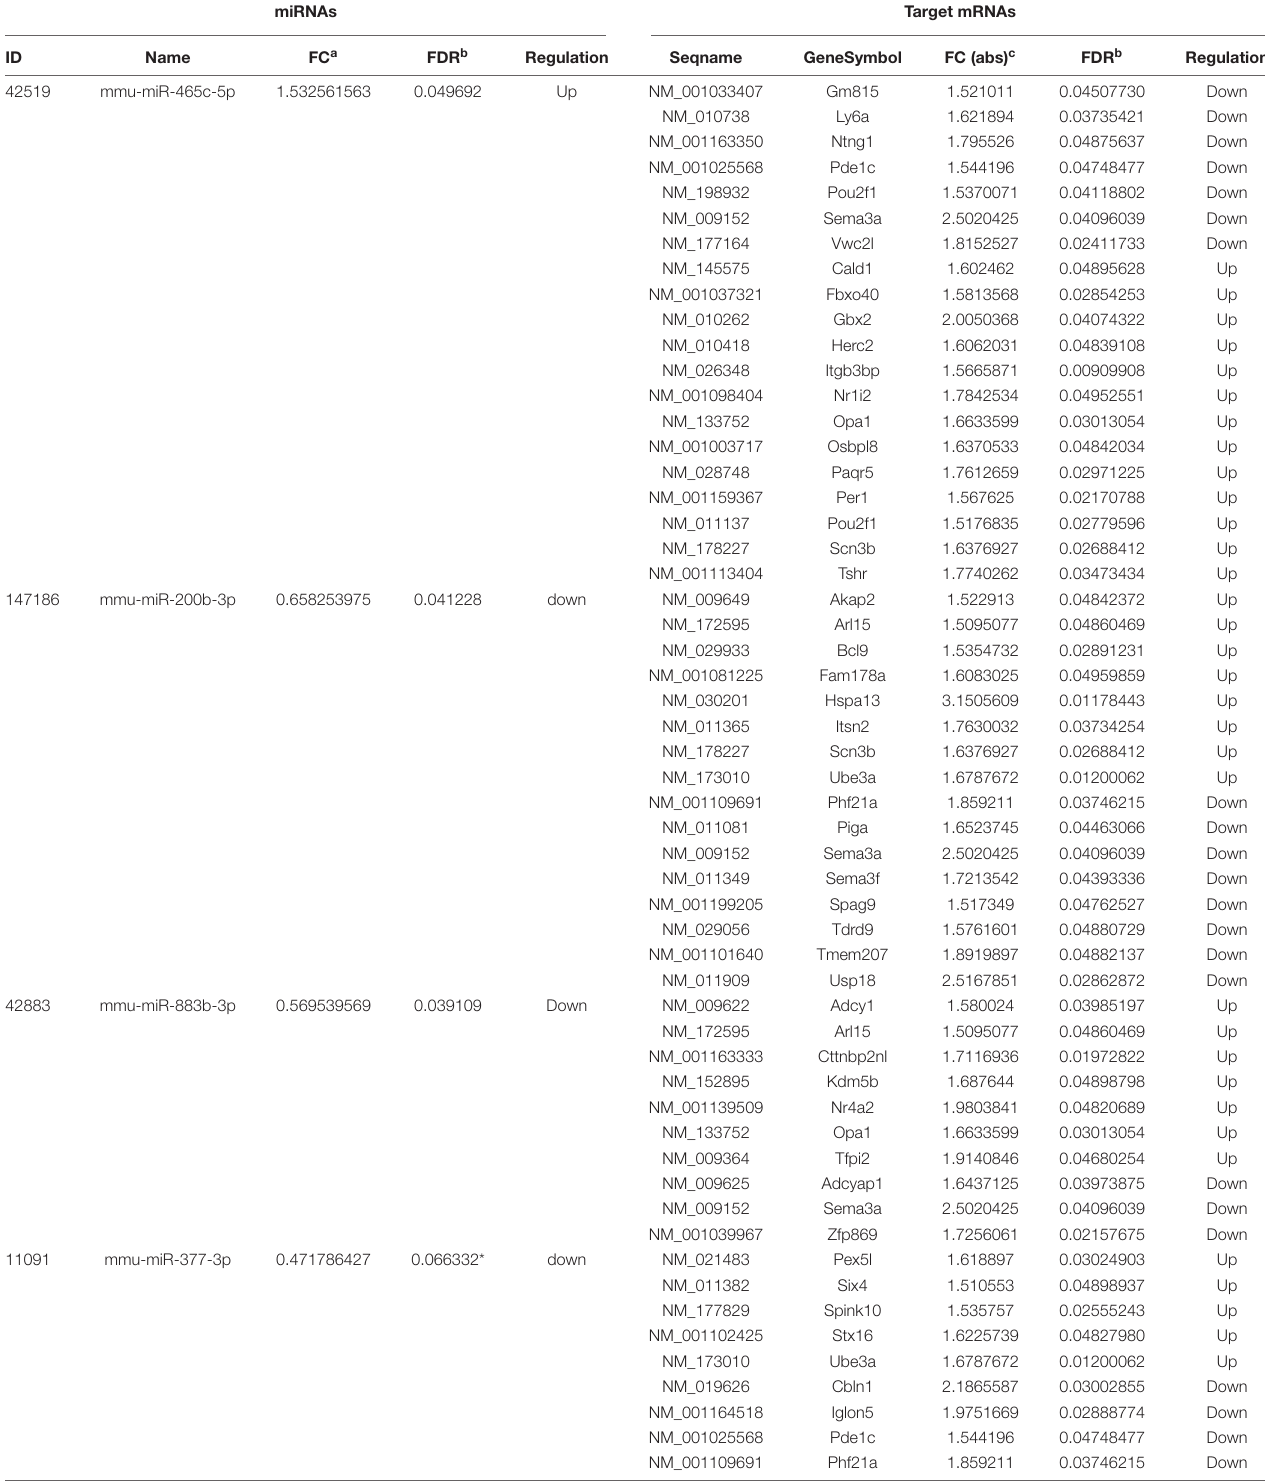
TABLE 1 | Differentially expressed miRNAs and their differentially expressed mRNA